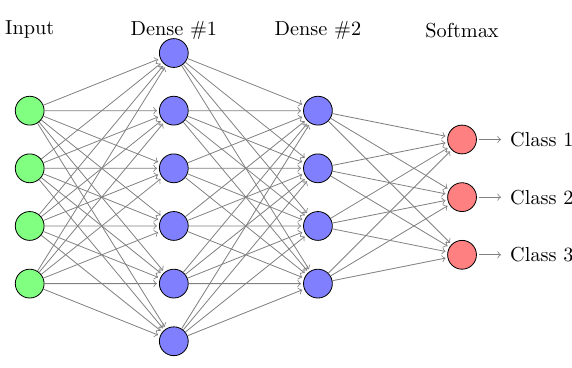
Figure 2. Example of fully-connected neural